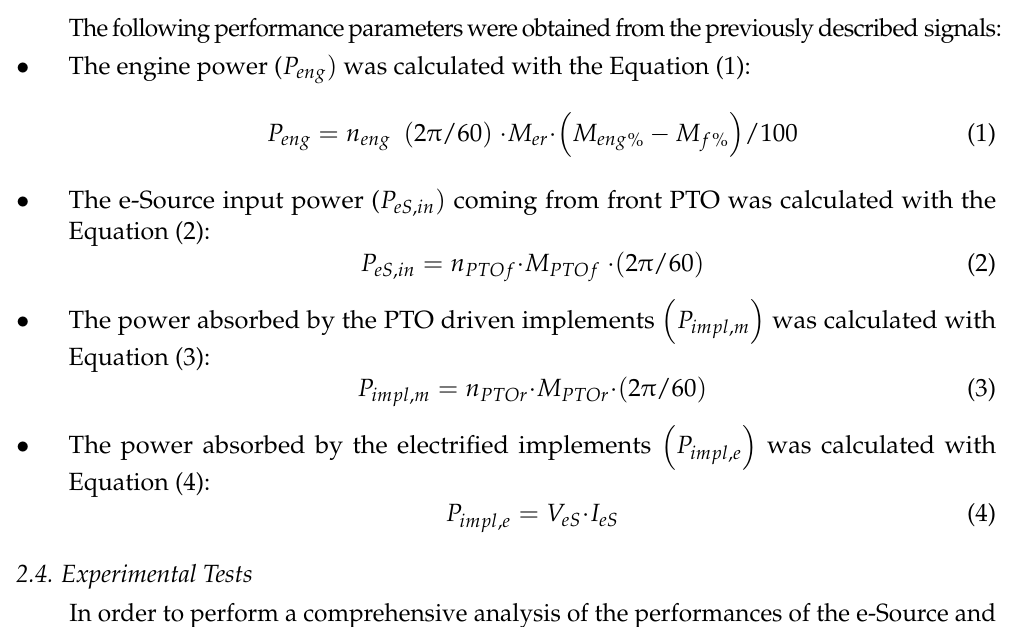
Figure 6. HAT 200-S current sensor installed inside the e-Source ( a ), custom-made sensored cardan shaft placed between the tractor front PTO and the power pack ( b ), Datum Electronics Series 420 torquemeter placed between the tractor rear PTO and the cardan shaft ( c ).